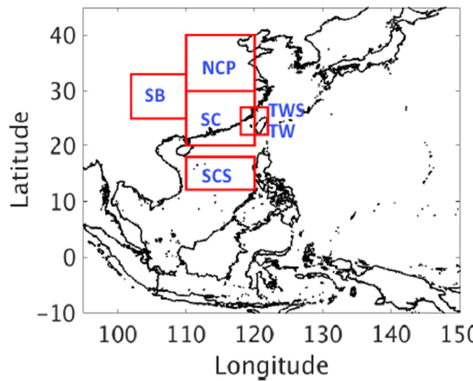
Figure 1. Summary of monitored regions, including North China Plain (NCP), Southeastern China (SC; land only), Sichuan Basin (SB), Taiwan Island (TW; land only), Taiwan Strait (TWS; sea only), and South China Sea (SCS).